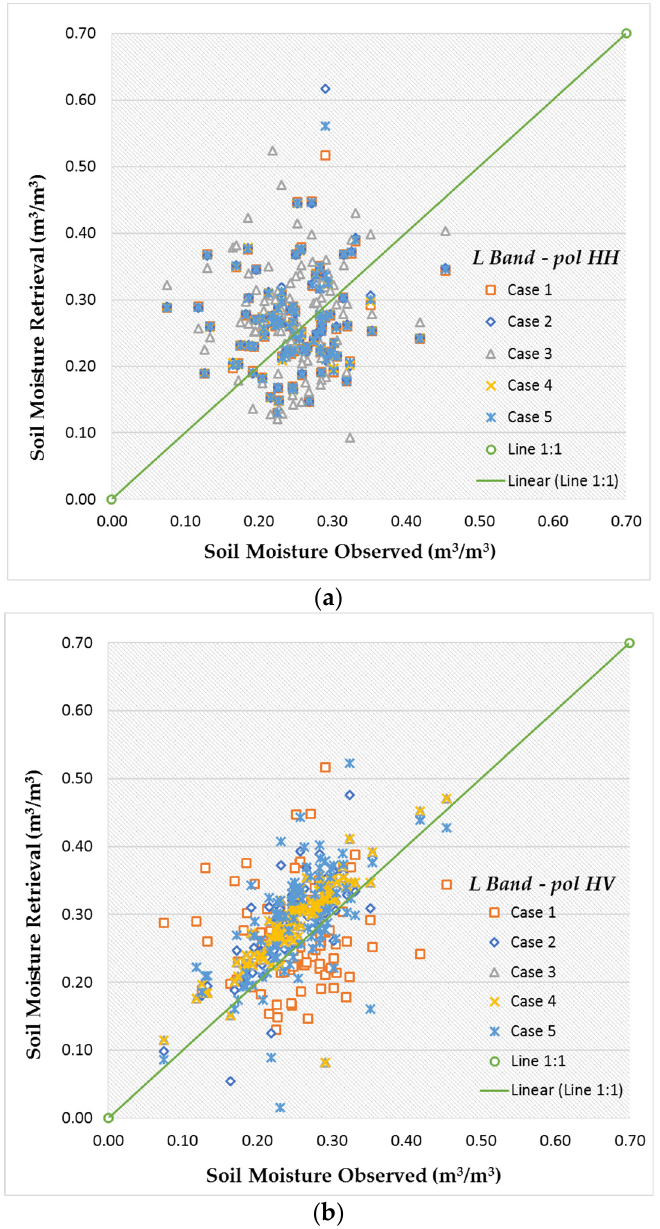
Figure 3. Observed soil moisture compared to retrieved soil moisture: Polarization in L band using ( a ) HH polarization and ( b ) HV polarization.